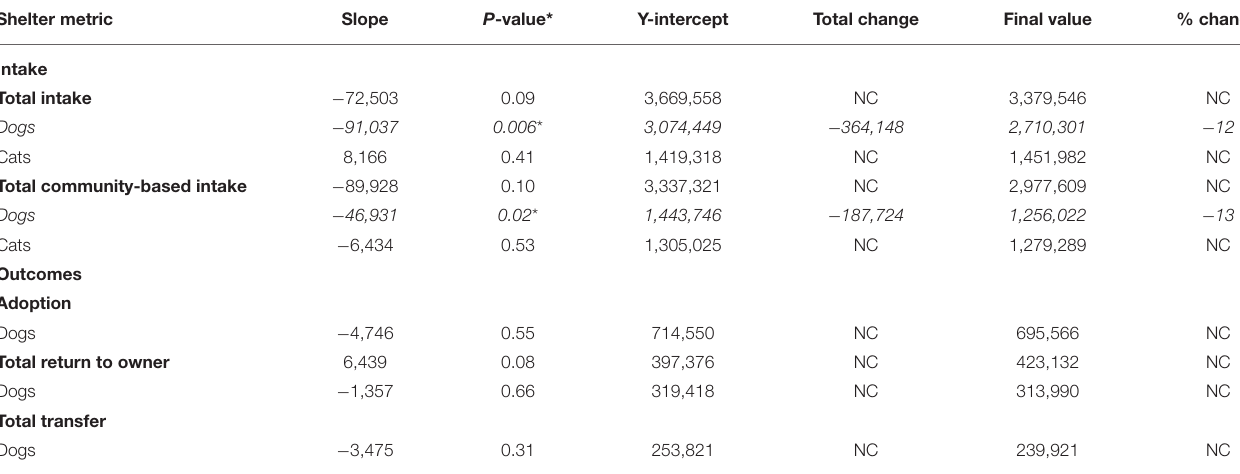
TABLE 4 | Results of linear regression analysis of intake and outcome subtypes (2016–2019), with intake and outcome subtypes in which 2020 was an outlier. Shelter